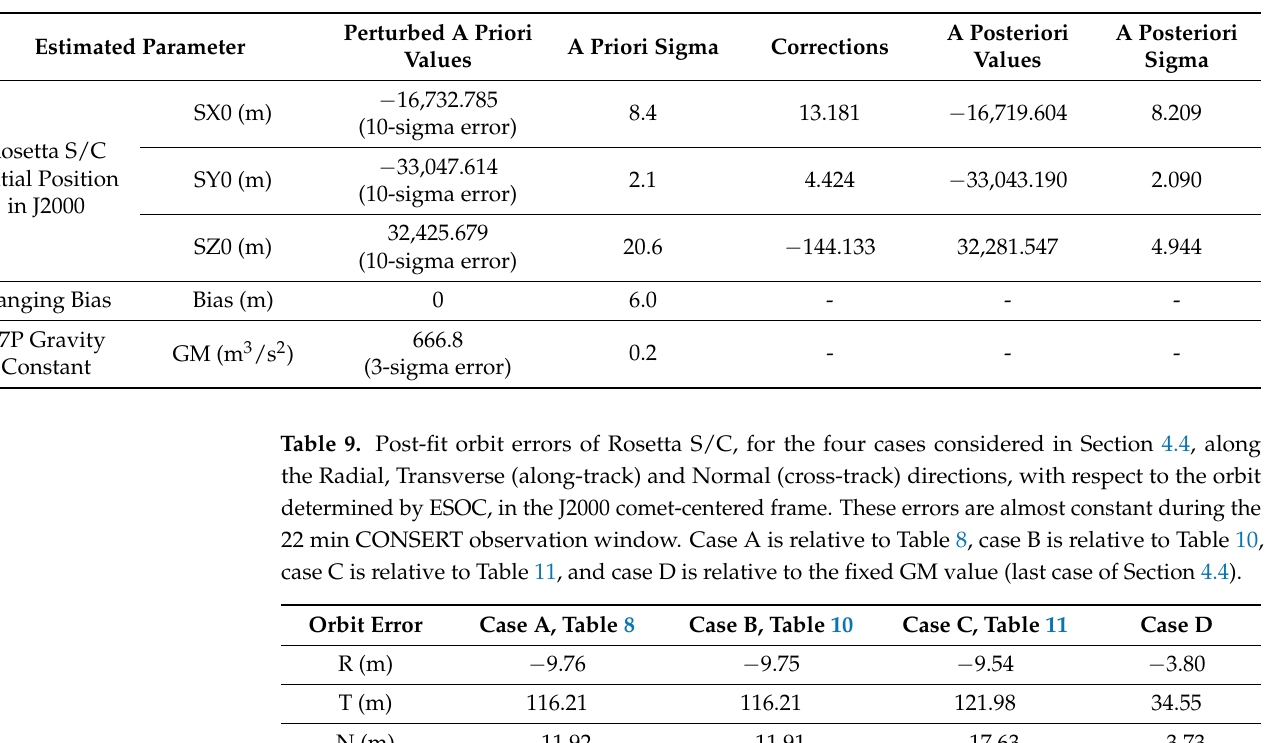
Table 8. Evaluation of navigation accuracy (case A). The Rosetta initial position vector has been perturbed with a 10-sigma error and the GM with a 3-sigma error. Post-fit orbit residuals are given in Table 9, first column. The Philae position is kept fixed to the coordinates given in Table 6.